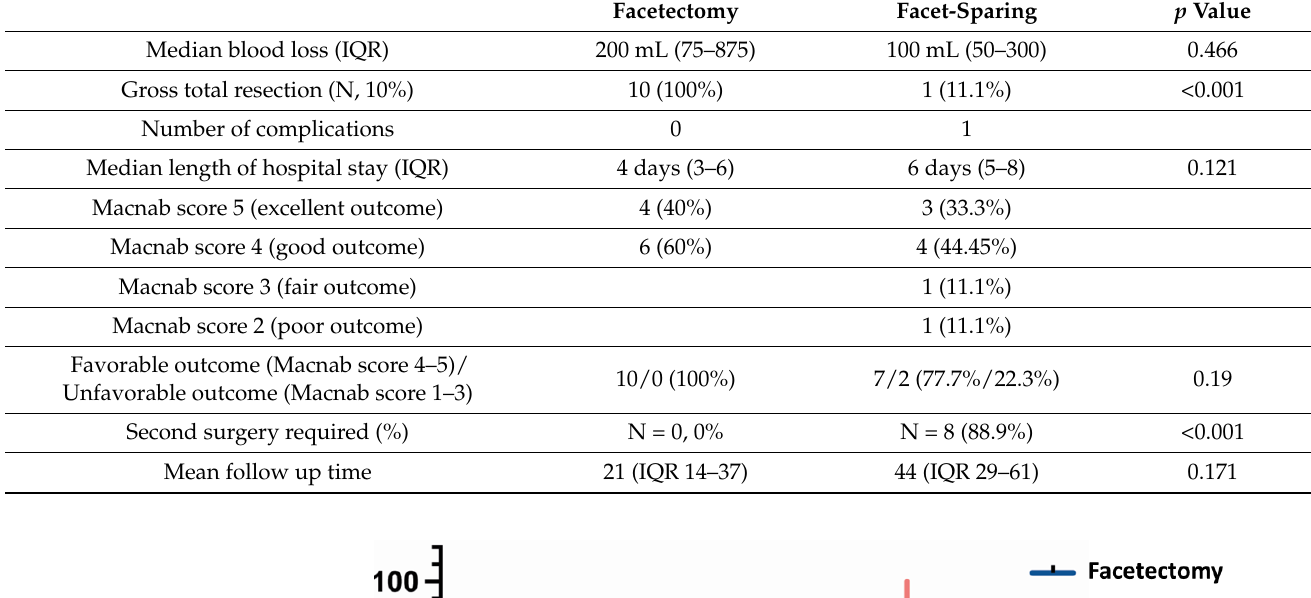
Table 2. Perioperative data and outcome.